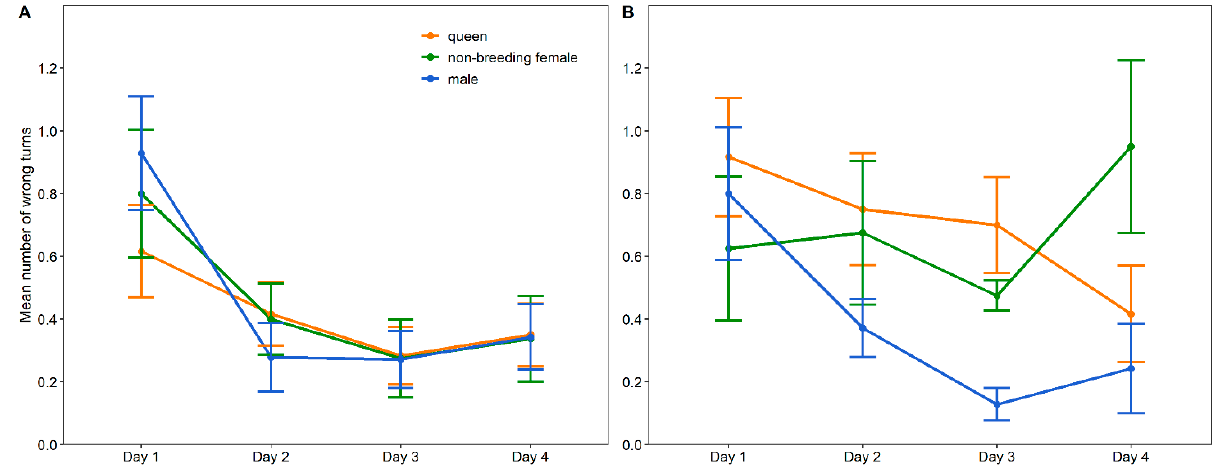
Figure 4. Mean number of wrong turns (±SE) made by colony- ( A ) and single-housed ( B ) Damaraland mole-rats in a Y-shaped maze on four consecutive days. Significant differences between the different groups are indicated in Table 3. Table 3. Significant post hoc differences in the mean number of wrong turns in Experiment 2 be- tween experimental day 1 and days 2, 3 and 4.